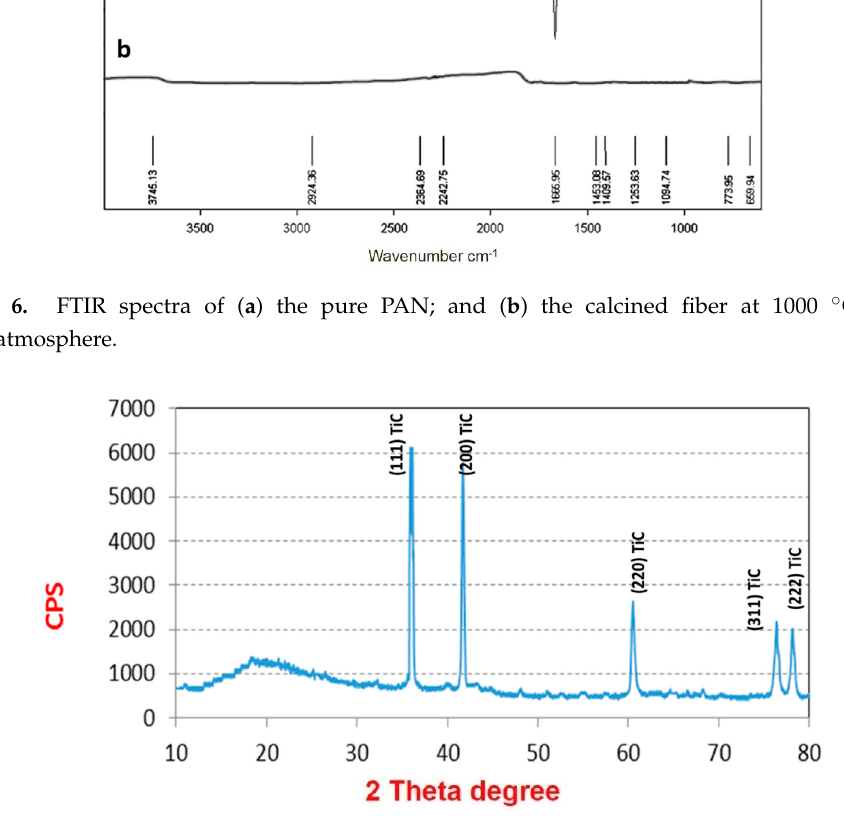
Figure 6. FTIR spectra of ( a ) the pure PAN; and ( b ) the calcined fiber at 1000 C under argon atmosphere.